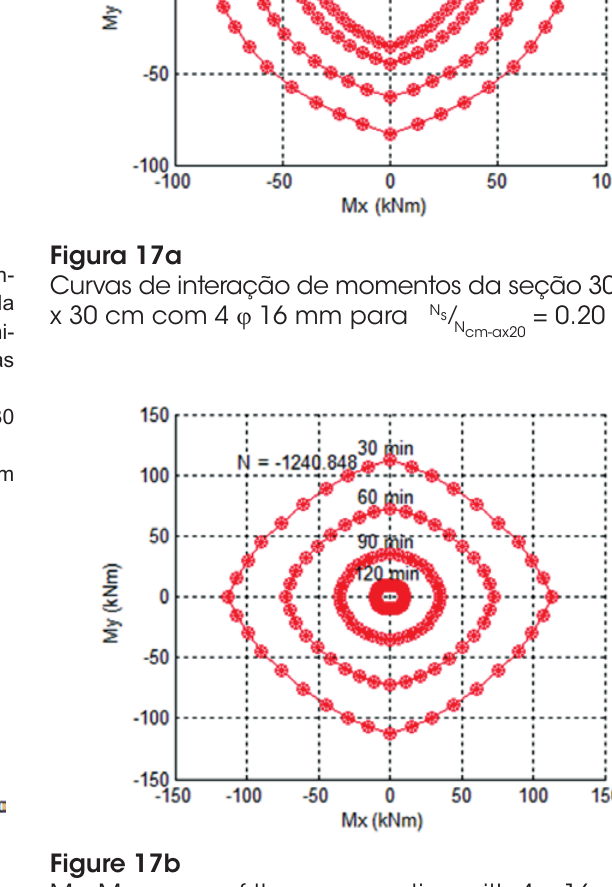
da seção 30 cm x 30 x